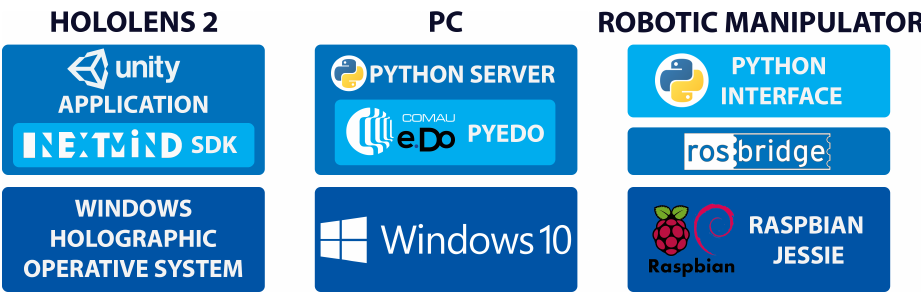
Figure 3. Software layers of the proposed